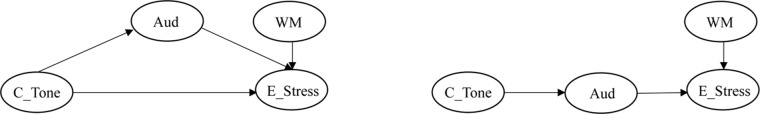
The partial mediation model (Left) and the full mediation model (Right) for the relation between Cantonese lexical tone sensitivity and English lexical stress sensitivity. C_Tone = Cantonese lexical tone sensitivity; E_Stress = English lexical stress sensitivity; Aud = General auditory sensitivity; WM = Working memory.